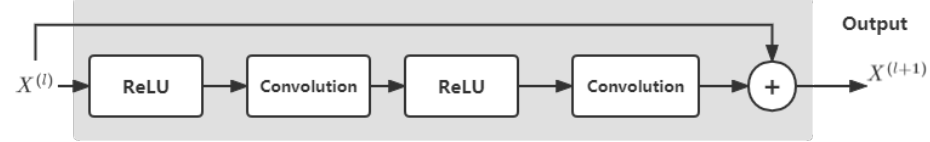
Figure 6. Schematic diagram of Resnet structure